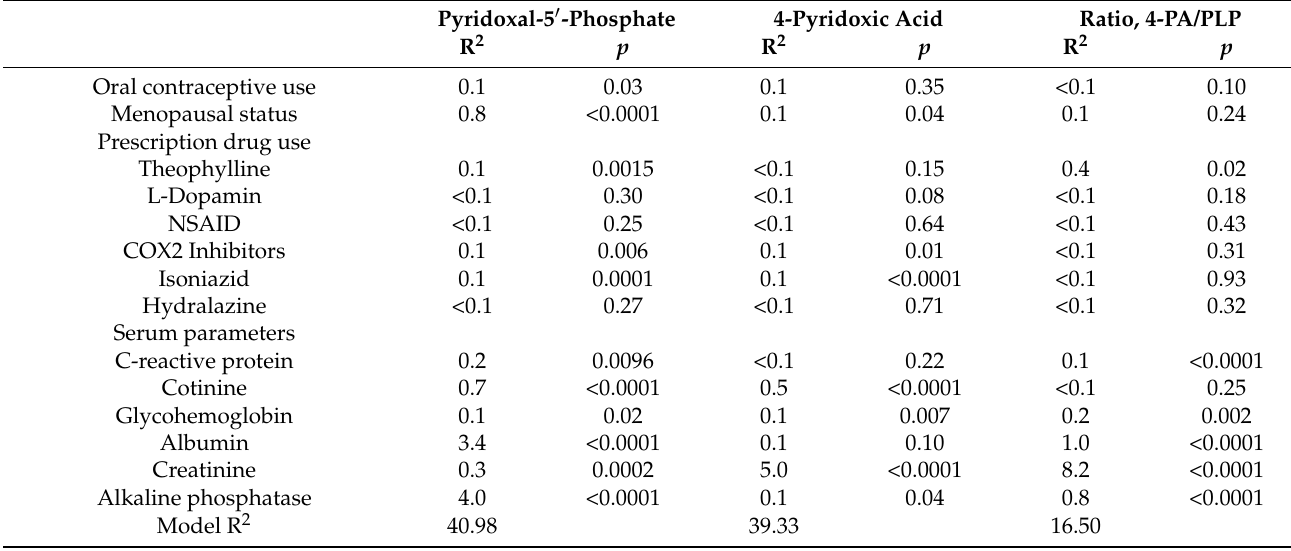
a Semi-partial R 2 values from a multivariable linear regression model mutually adjusted for all variables in the table. Due to missing biomarker values among 83 participants (n missing for CRP = 9, cotinine = 23, glycosylated hemoglobin = 15, albumin = 62, creatinine = 63, alkaline phosphatase = 63) Model 2 included data of n = 8885